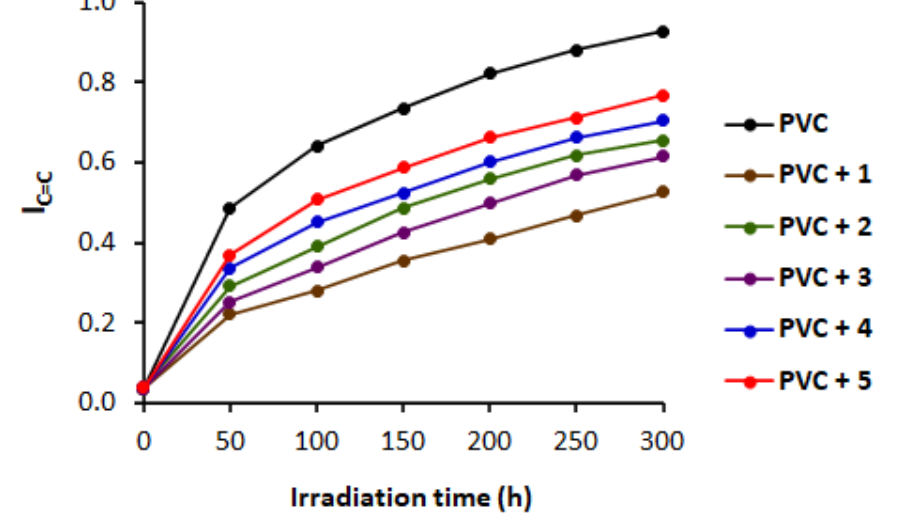
Figure 7. The I C=C index against irradiation time for PVC